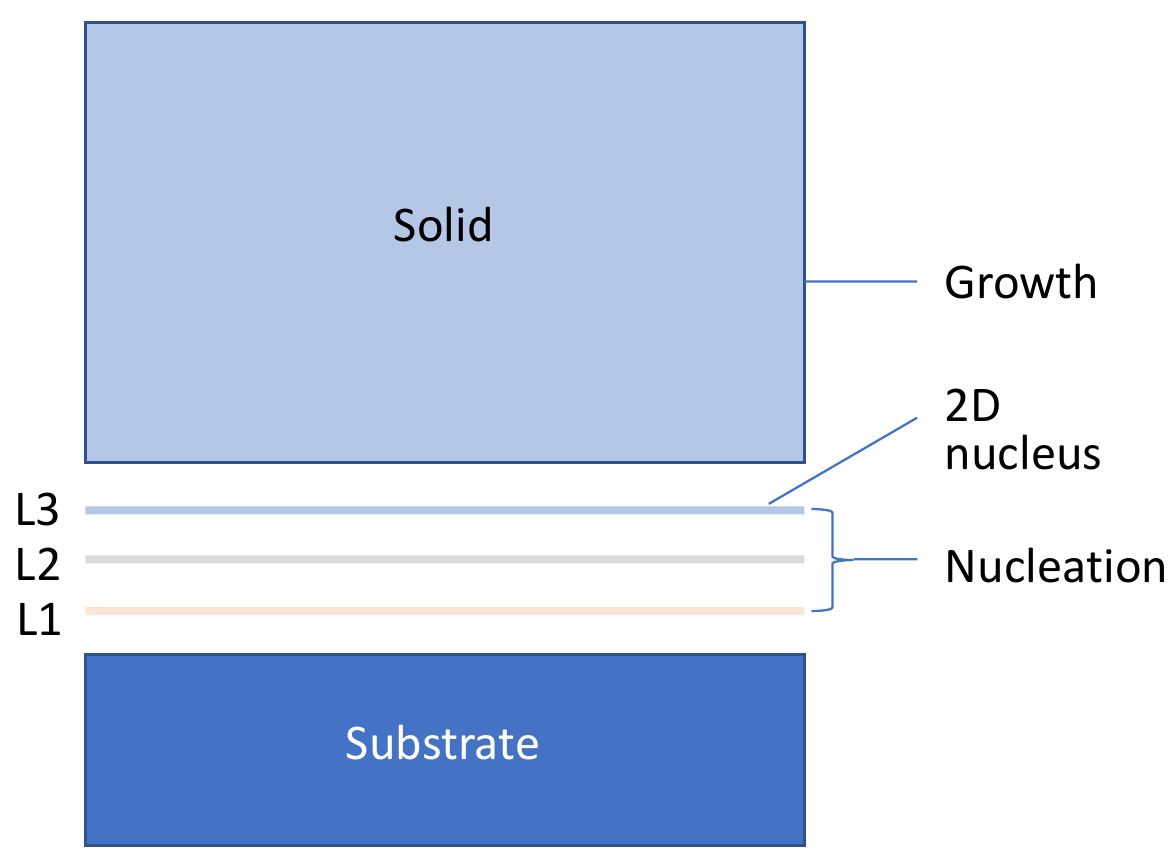
Figure 19. Schematic illustration of the 3-layer nucleation mechanism. At the nucleation temperature, heterogeneous nucleation starts with a precursor created by the prenucleation, proceeds layer-by- layer through a structural templating mechanism, and completes within 3 atomic layers (marked as L1, L2 and L3) to provide a 2D nucleus (a crystal plane of the solid) which can template further growth of the